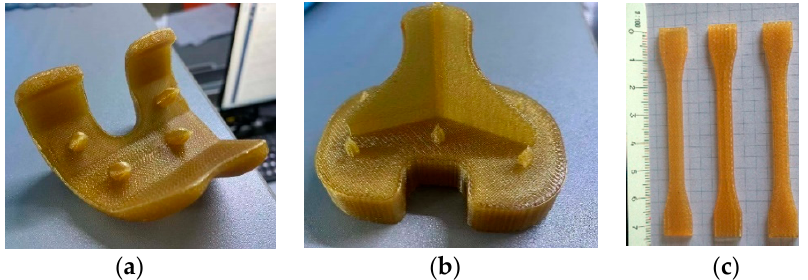
Figure 3. Parts manufactured by FDM technology: ( a ) femoral part; ( b ) tibial part; ( c ) 1BA specimens for tensile tests (XY-XZ-YZ orientation).